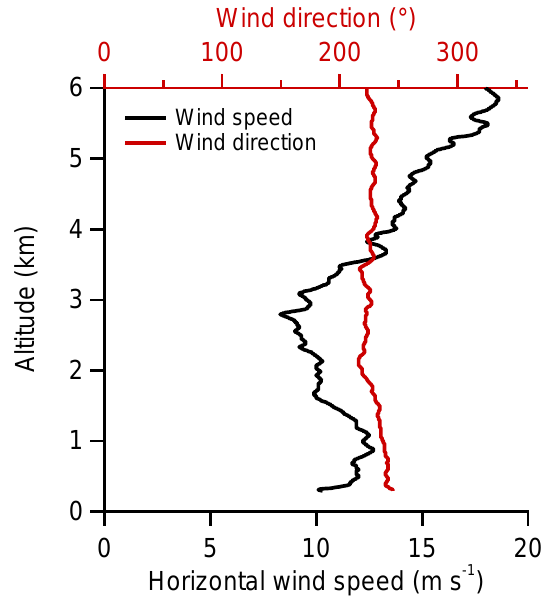
Figure 2. Vertical profile of horizontal wind speed and direction measured from the 15:00UTC radiosonde launched from David- stow, the same location as the NCAS precipitation